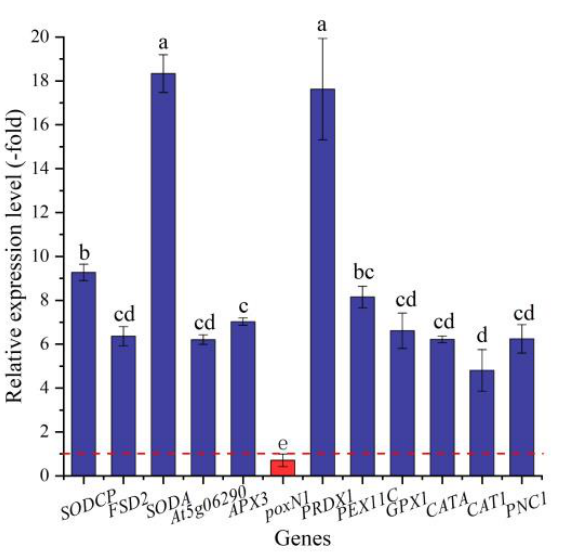
Figure 7. The RELs of genes directly associated with antioxidant enzymes in A. venetum seeds at 300 mmol/L NaCl vs. CK (mean ± SD, n = 3). Different letters represent a significant difference ( p < 0.05) among different genes. The red dotted line differentiates UR (>1) and DR (<1).